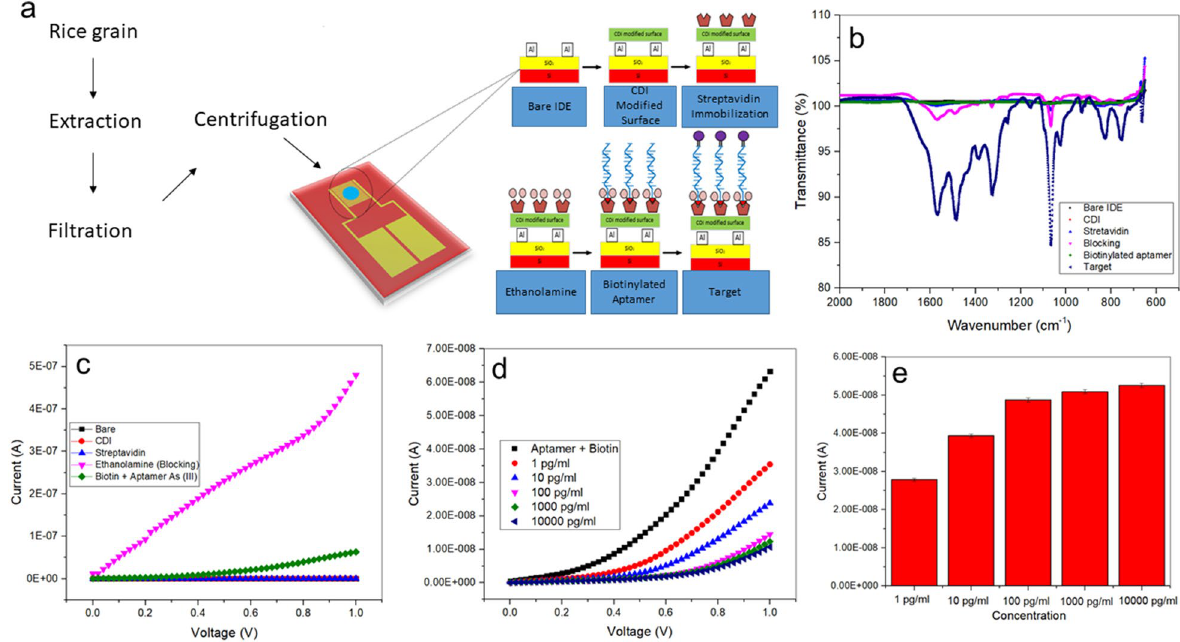
Figure 4. Schematic representation of the strategy for the detection of arsenic using Al IDE. ( a ) Sample preparation of rice grains. At first, 1.3 g of grains were smashed into small pieces and placed in conical flasks. Next, the samples were perfused with 15 ml of nitric acid, followed by 5 ml perchloric acid, and heated at 90 °C. At this stage, the samples acquired a yellow color and they were heated and filtered. All filtered solutions were diluted with 50 ml of distilled water and ready to be used. ( b ) I–V measurement based on surface immobilization and functionalization. CDI and streptavidin were used to modify the sensor surface of Al IDEs. Then, the remaining surface was blocked by ethanolamine. The biotinylated aptamer was immobilized on the IDE sensing surface. ( c ) FTIR analysis was used to evaluate the surface functionality at every stage of the modifying process of the Al IDE until reaching the target measurement. ( d ) Analysis of the interaction between biotinylated aptamer and arsenic at concentrations ranging from 0.01 µg/ml to 0.001 ng/ml. ( e ) Current measurements at the different concentrations of arsenic using the biotinylated aptamer Al